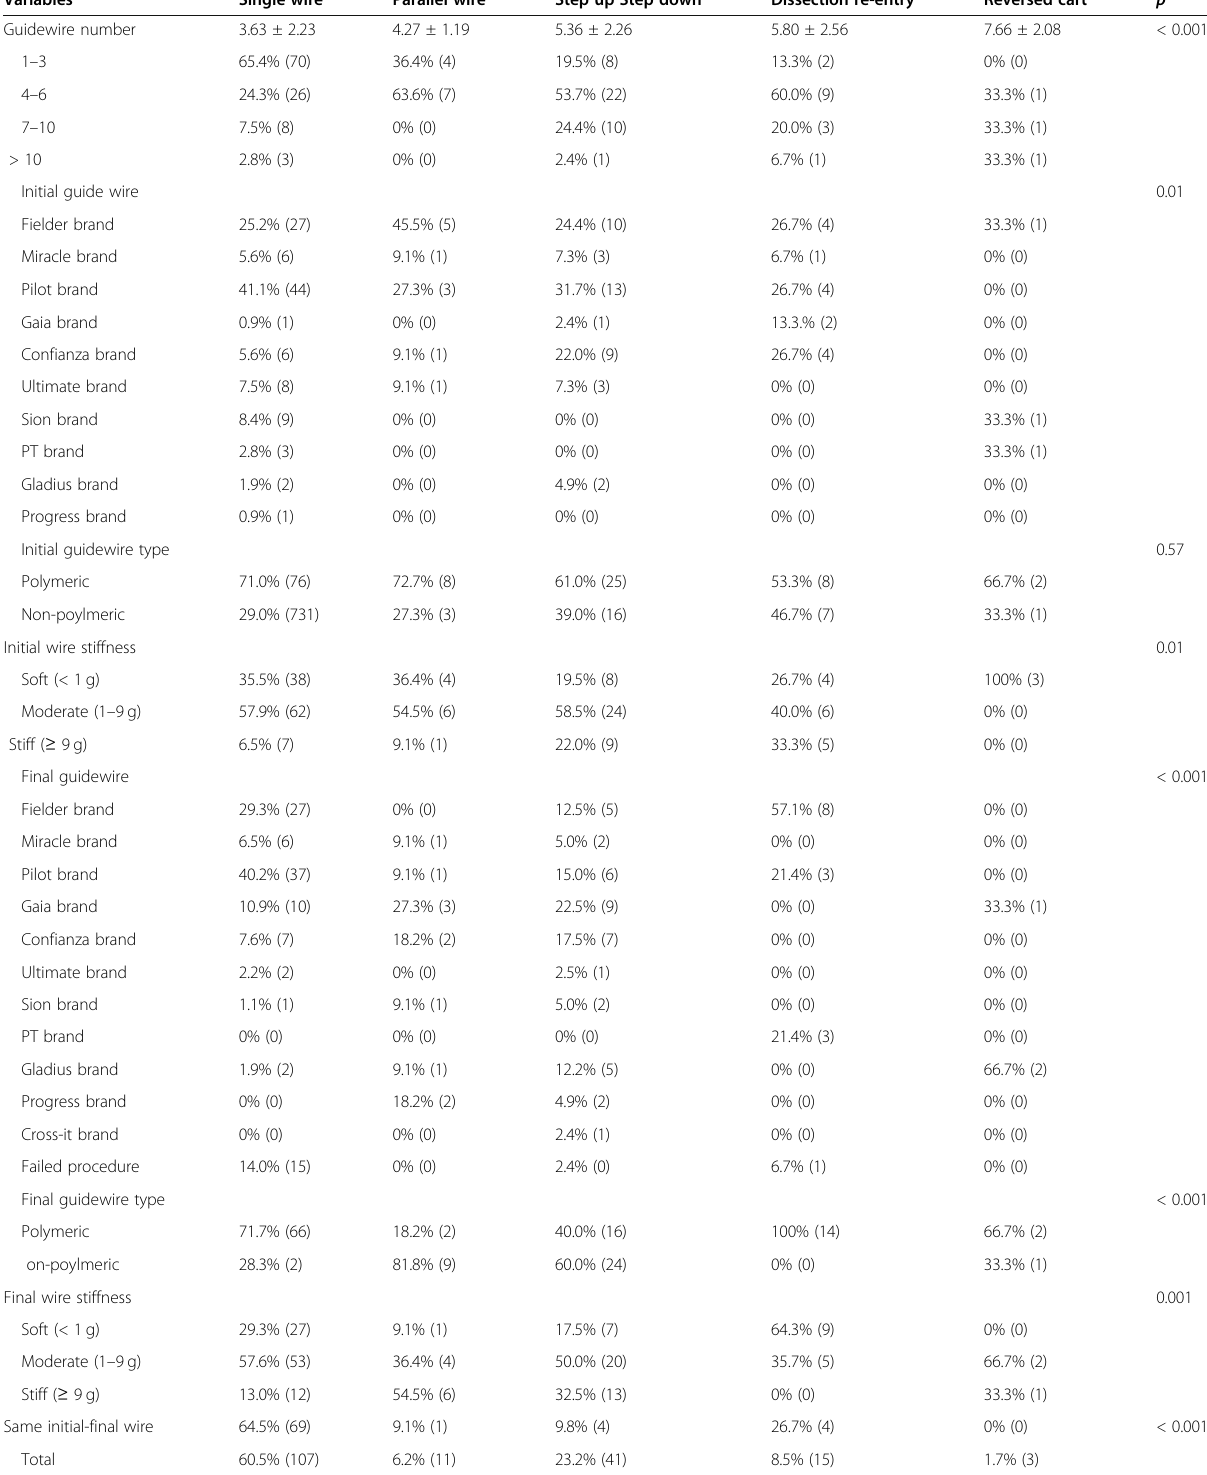
Table 5 Distribution of first-choice and final crossing guidewires characteristics according to a procedural